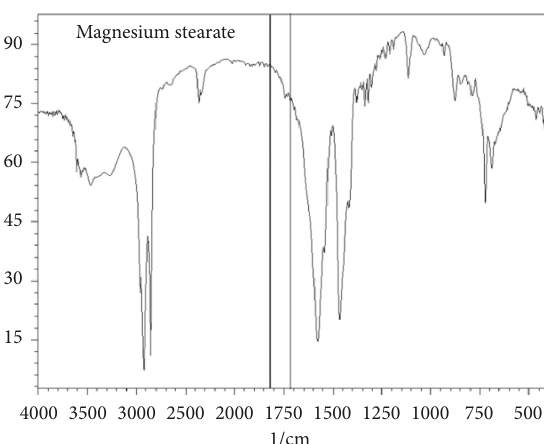
Figure 2: Absorption spectra in the mid-infrared region of the adjuvants present in the pharmaceutical dosage form of the capsule. Spectral range chosen for quantitative analysis (from 1815 to 1736cm